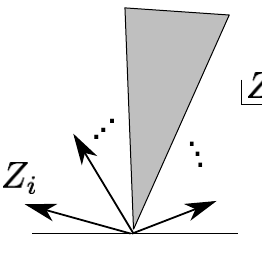
Figure 1 . Infinite BPS spectrum: generic structure. In the grey shaded region a dense subset with higher spin BPS particles. The dots stand for an accumulating sequence of